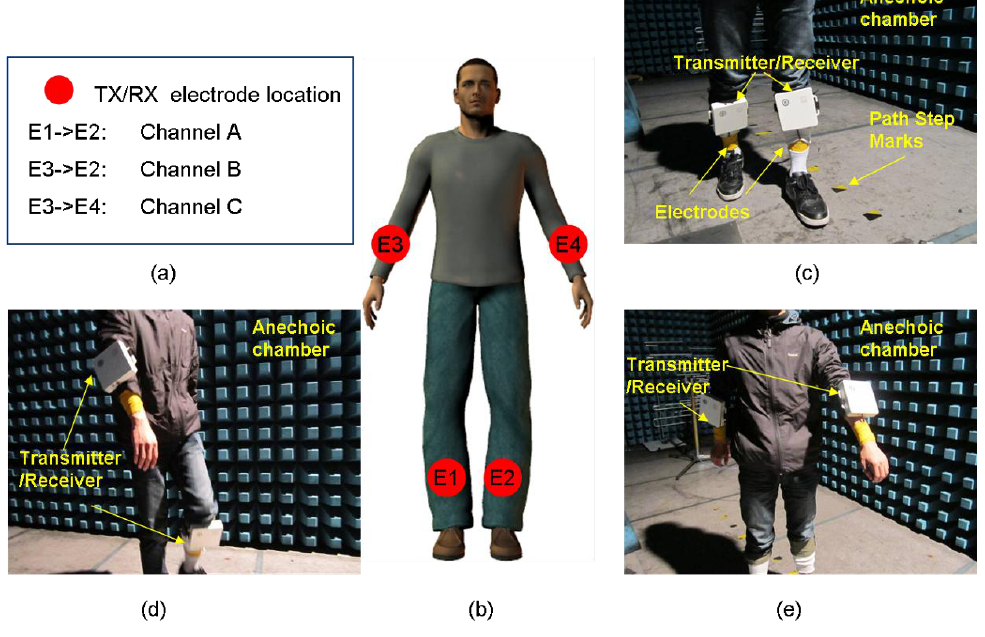
example, ‗E1->E2: Channel A‘ indicates that channel A was defined as the channel between locations E1 and E2. ( b ) Electrode locations. E1 was located on the right lower leg, E2 was placed on the left lower leg, E3 was located on the right wrist, and E4 was placed on the left wrist. ( c ) Photograph of the channel A measurement scenario. ( d ) Photograph of the channel B measurement scenario. ( e ) Photograph of the channel C measurement